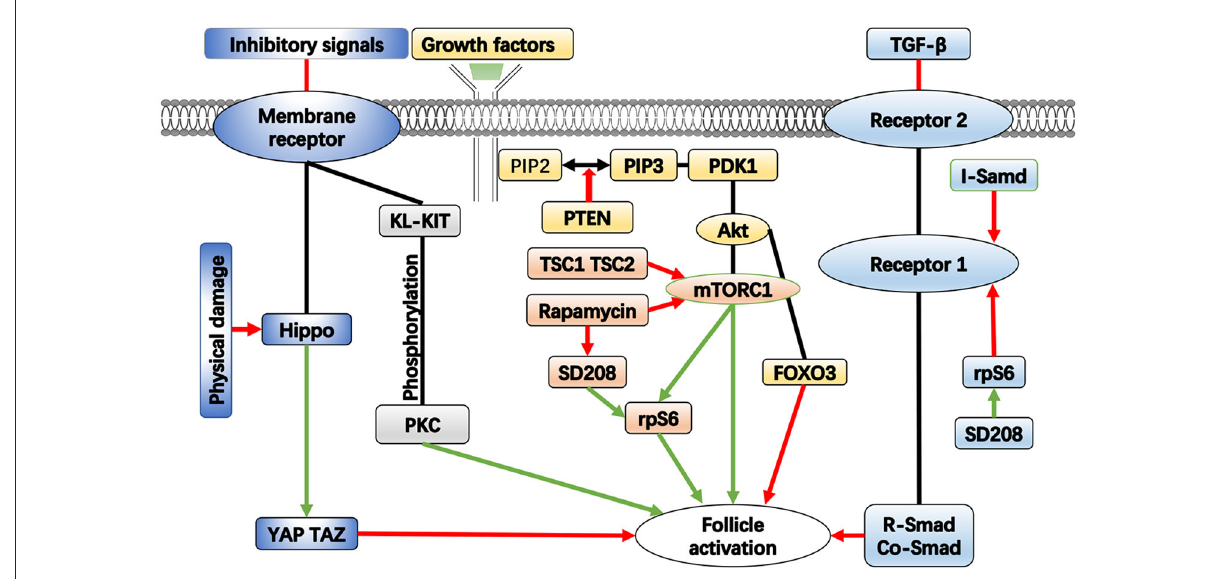
FIGURE1 The important pathways in the activation of follicle. Green arrows represent enhancement, red arrows represent